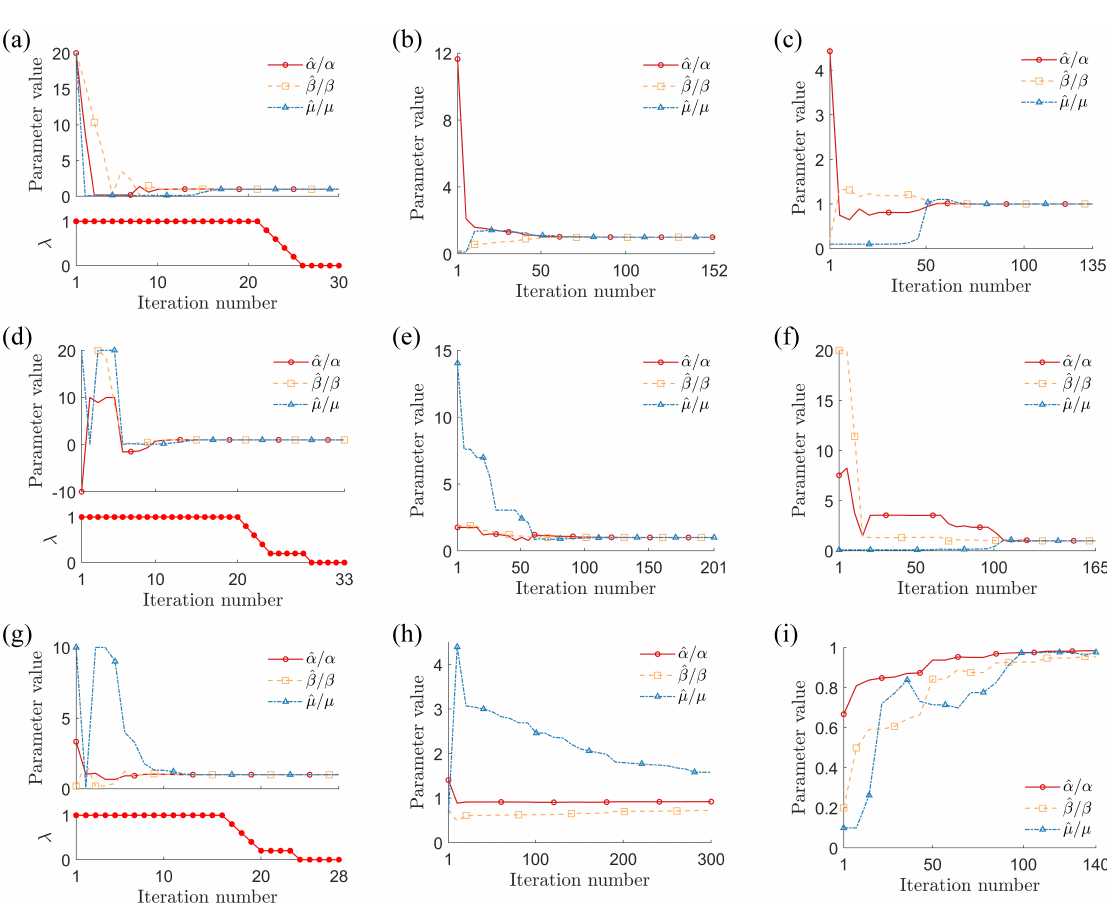
Figure 2. Evolution of parameter estimates (normalized relative to experimental values) for three van der Pol–Duffing oscillators: ( a – c ) single-well, ( d – f ) double-well, and ( g – i ) double-hump. ( a , d , g ): parameter identification using proportional–derivative controller; ( b , e , h ): parameter identification using genetic algorithm; ( c , f , i ): parameter identification using particle swarm